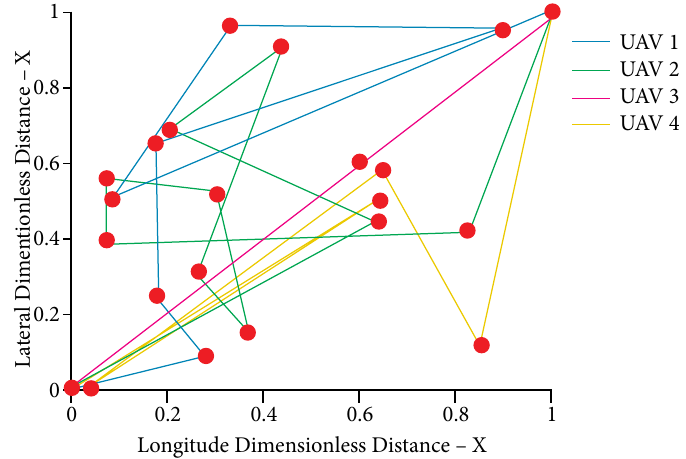
Figure 8. The first iteration for 4 UAVs